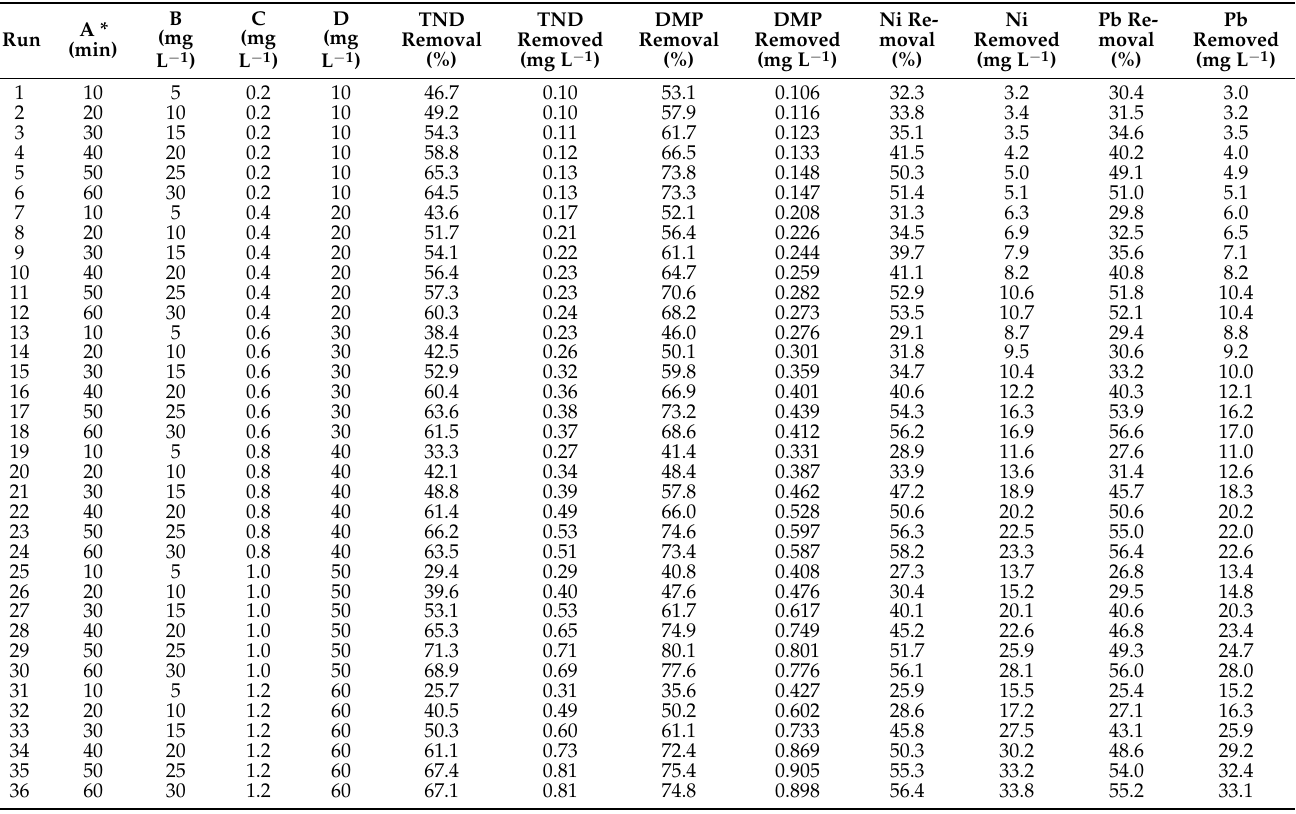
Table 2. Removal values for different independent